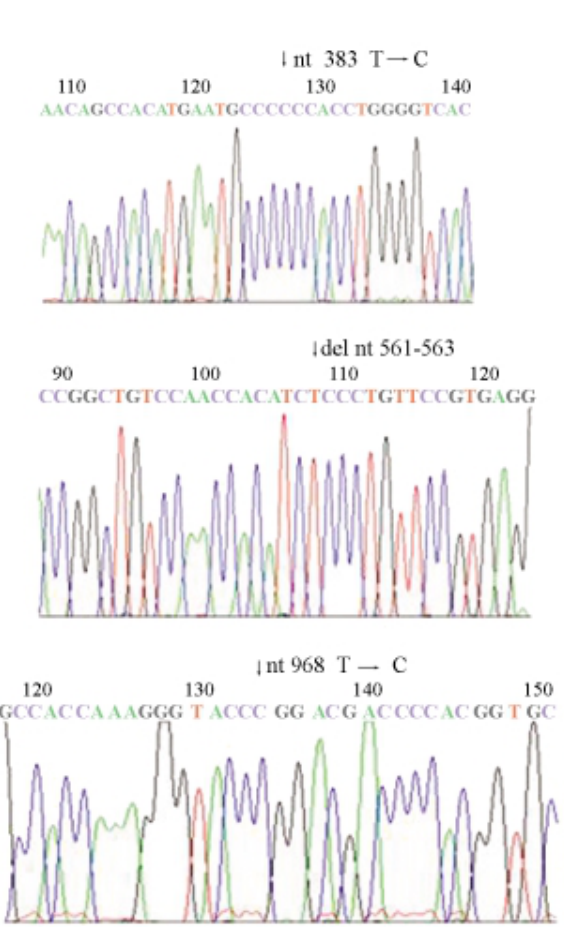
Figure 1 - Sequence analysis of a portion of exons 5, 6, and 9 showing the mutationsatnt383T (cid:1) C,delnt561-563,andnt968T (cid:1) Crespectively.